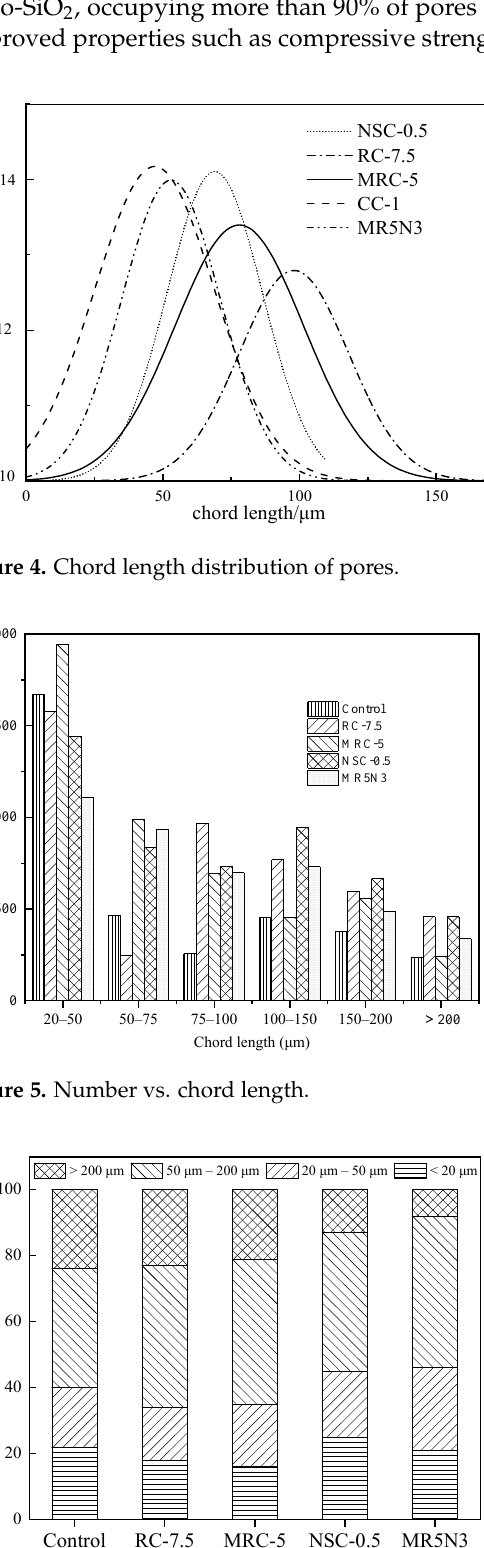
Figure 5. Number vs. chord length.